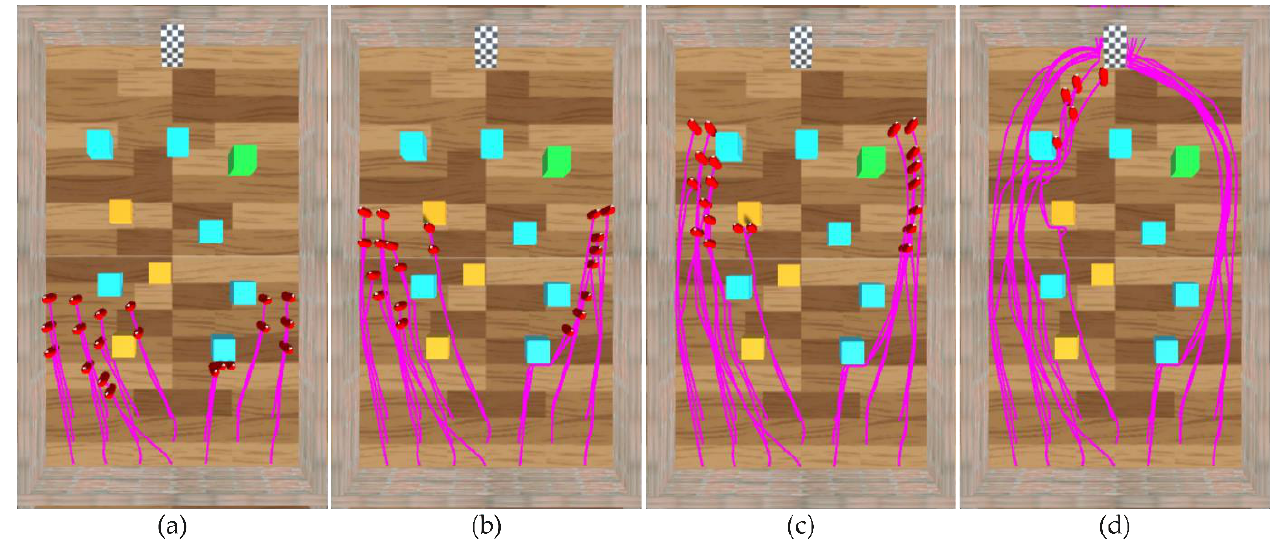
Figure 11. A temporal sequence of an experimental result generated by the method of [27] in the adjusted scenario II. ( a – d ) Stills of the experimental result. The temporal sequence of these stills is sorted alphabetically.